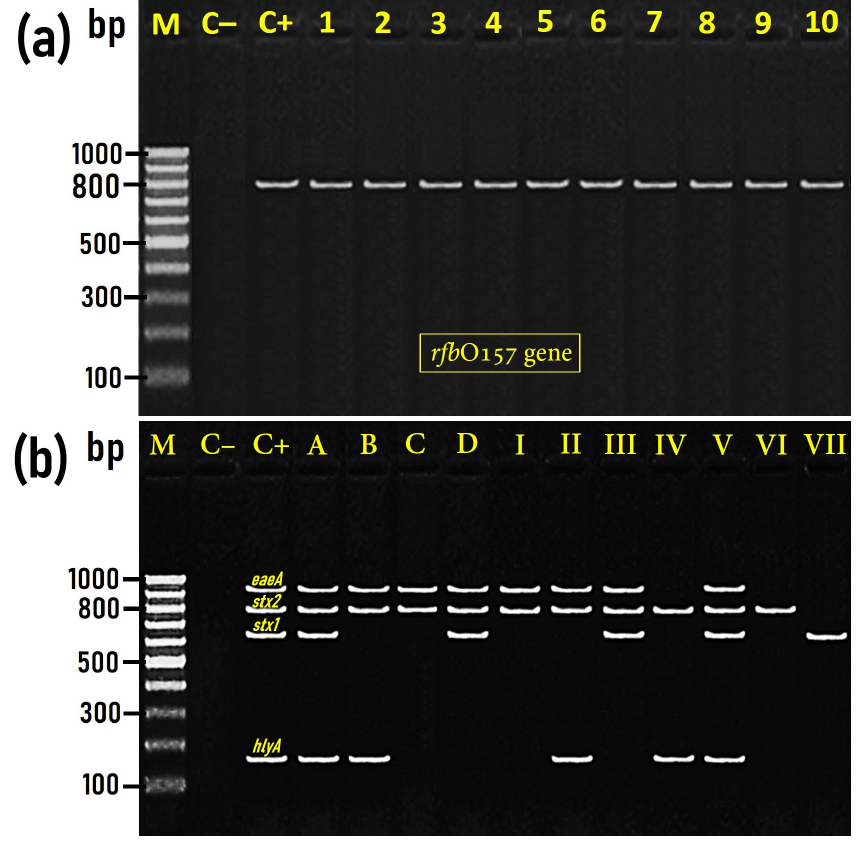
Figure 2. Representative agarose gel electrophoresis image for PCR amplicon of the rfb O157 gene (800 bp) characteristic for Escherichia coli O157:H7 ( Panel ( a )) and for the multiplex PCR products of stx1 (614 bp), stx2 (779 bp), eaeA (890 bp), and hlyA (165 bp) virulence genetic markers in both E . coli O157:H7 and E . coli O55:H7 ( Panel ( b )). M, 100 bp ladder as a molecular DNA marker; Lane C–,